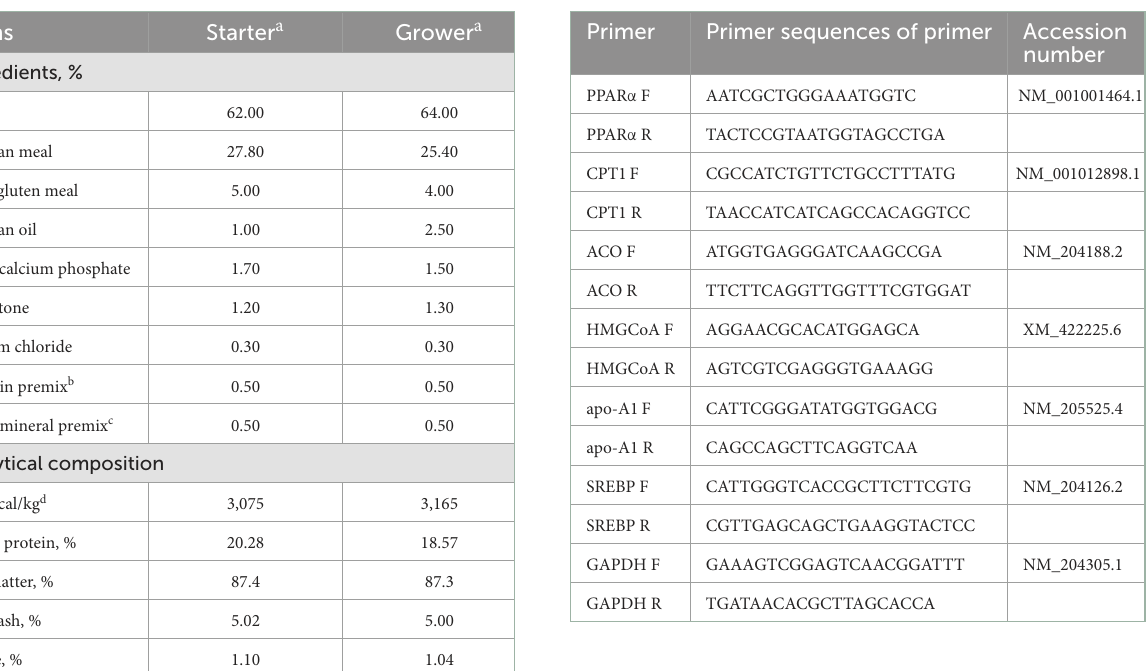
TABLE 1 Diet composition (as-fed basis). TABLE 2 Primer sequences of